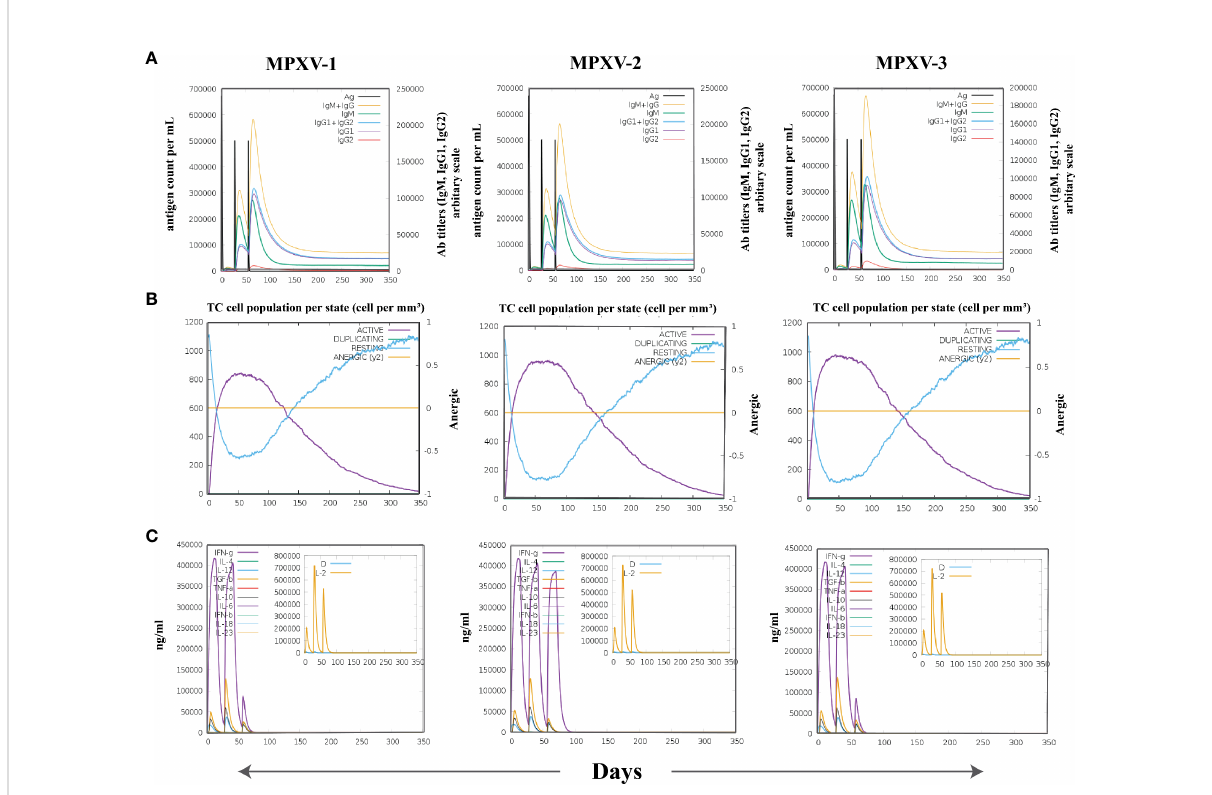
FIGURE 9 The spectrum of immune stimulated response. (A) Antibodies response against antigenic vaccine. Different colours re fl ected the formation of antibodies that signi fi ed the development of the immune response following vaccination and the diverse subtypes of immunoglobulins. (B) Cytotoxic T cell population in different states. (C) Cell population of cytokine and interleukin in the active and resting states with smaller graph depicting the Simpson